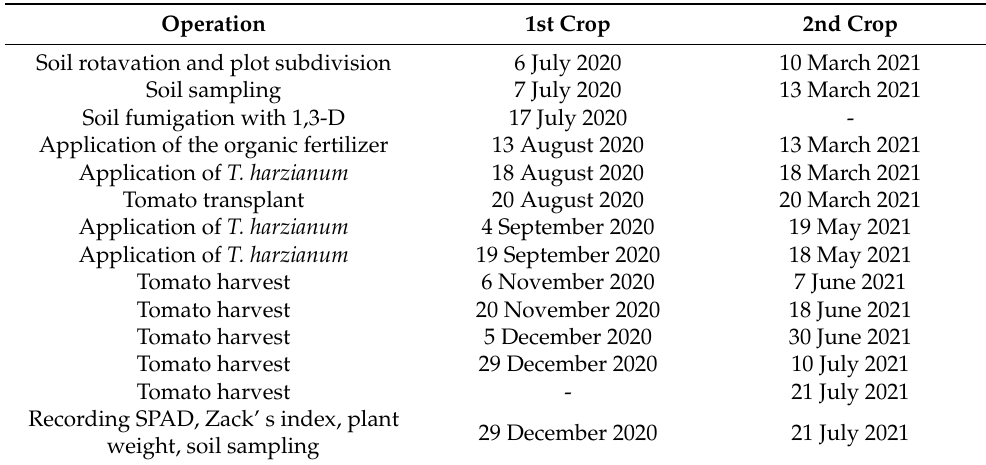
Table 1. Timetable (month/day/year) of experimental treatments and cultural practices of the two tomato crops. Operation 1st Crop 2nd Crop Soil rotavation and plot